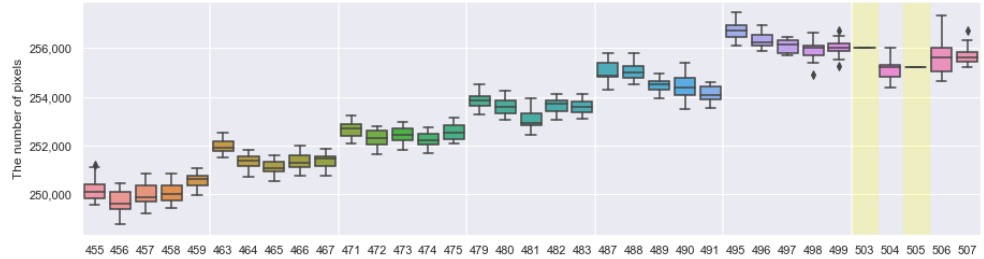
Figure A8. 1–7 October.